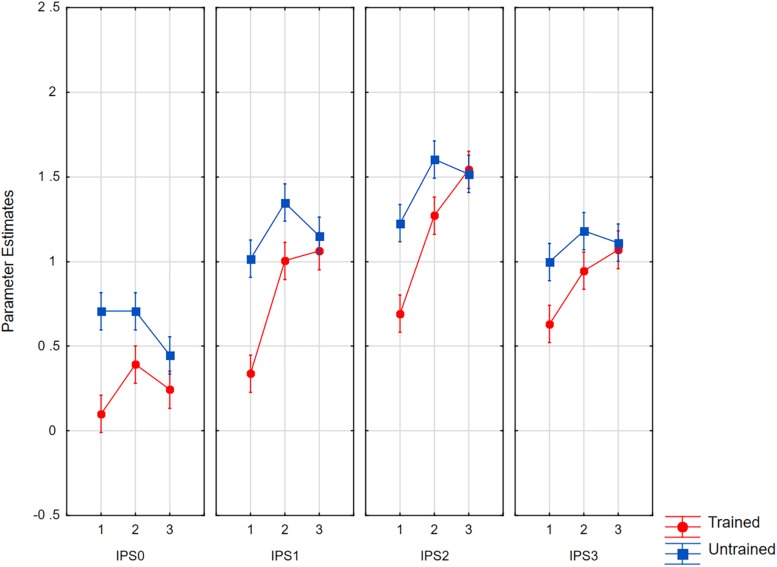
Parameter estimates for average activity in the left IPS0 to IPS3 volumes as a function of set size and item status. Whiskers show within subject confidence intervals based on the error term of the triple interaction according to Loftus and Masson (1994).